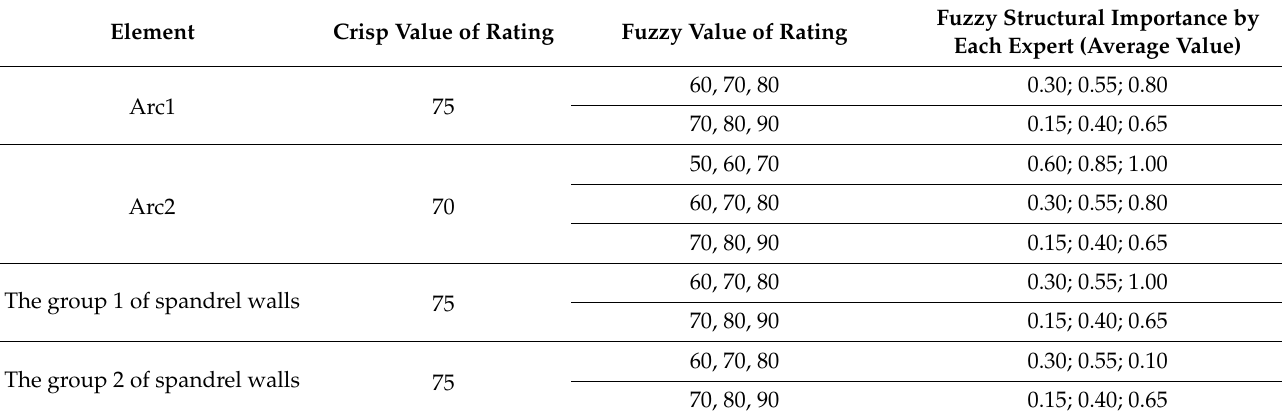
Table 4. Crisp and fuzzy values of the superstructure component elements.